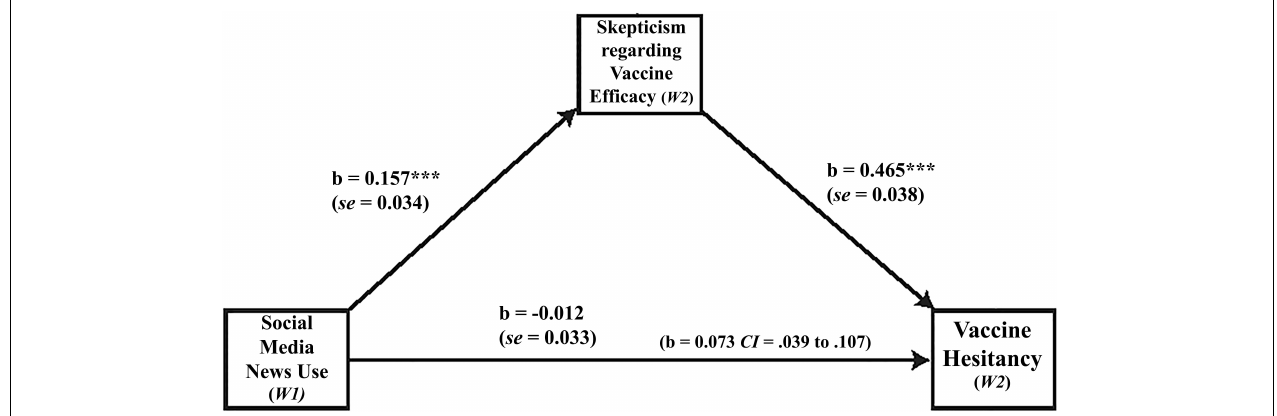
FIGURE 2 | Indirect effects of social media news use (w1) on vaccine hesitancy through skepticism. *** p < 0.001, ** p < 0.01; Estimates are calculated using the PROCESS macro for SPSS (Model 4; Hayes, 2018). The number in the parenthesis is the indirect effect with LLCI to ULCI. Bootstrap resample = 5,000. Statistical controls include age , gender , education , income , race , political trust , political interest , political efficacy , partisanship , traditional media news use , news trust , and news literacy .